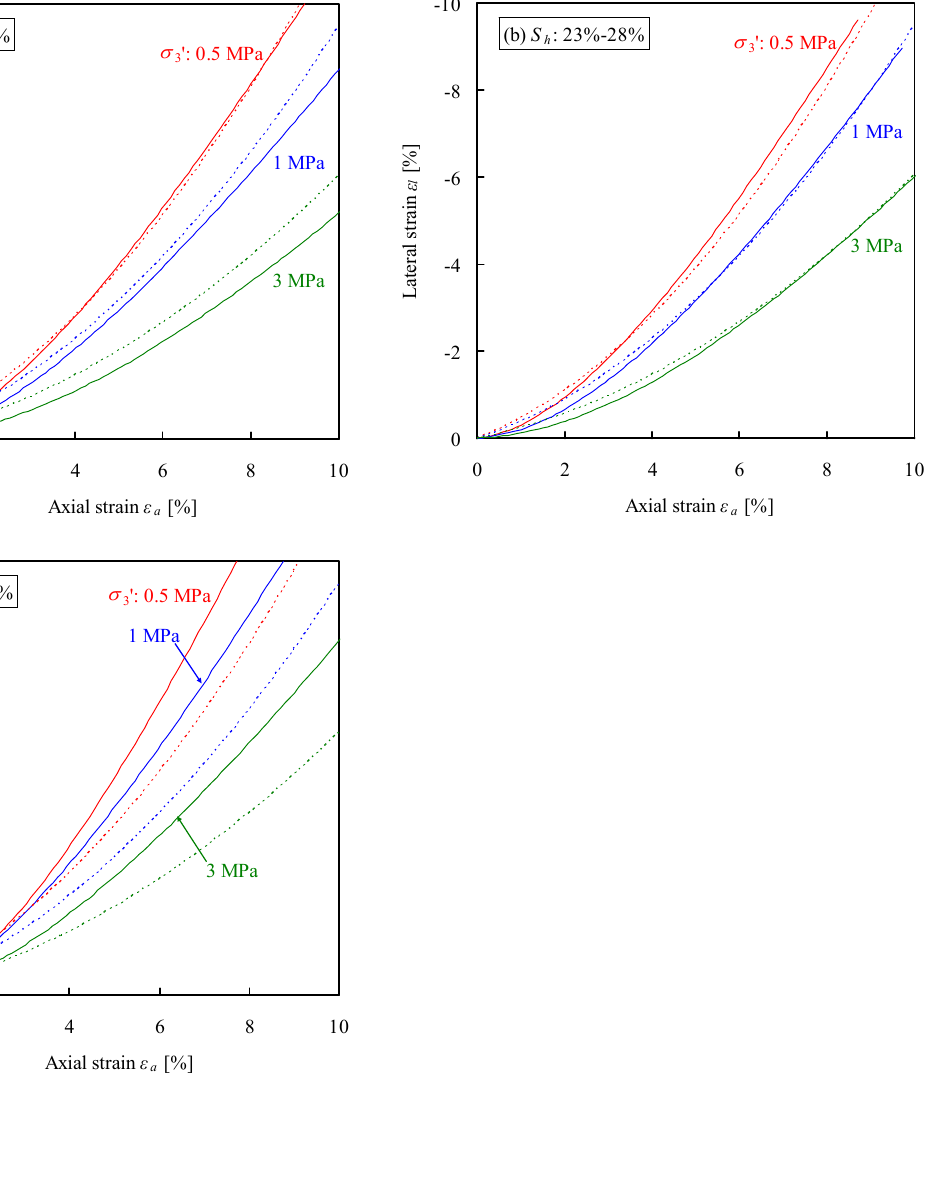
Figure 4. Experimental (solid lines) and calculated (broken lines) lateral strain ε for specimens formed by No. 7 silica sand with methane hydrate saturation axial strain ε a S of ( a ) 0%; ( b ) 23%–28% and ( c ) 49%. Experimental results are taken from the h reference